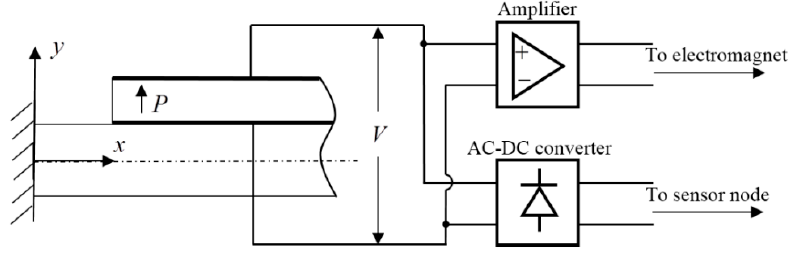
Figure 2. Electrode connections.